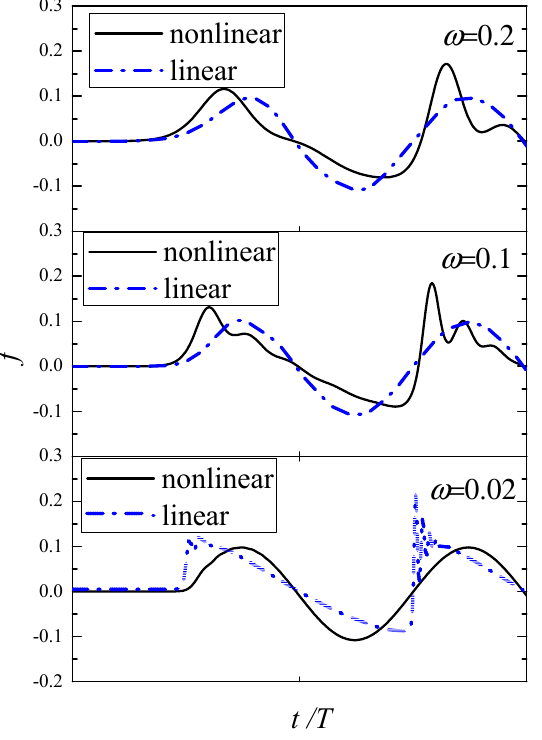
Figure 9. Evolution of wave profiles for the case of double-crest wave train.